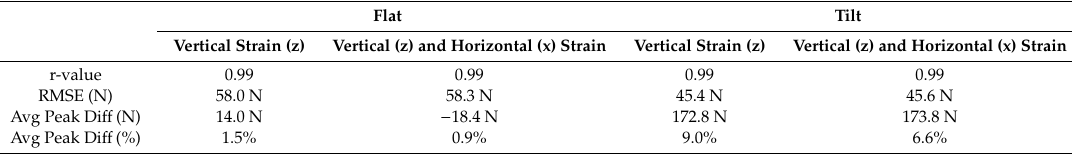
Table 2. E ff ects of blade tilt on blade force accuracy. The blade calibration was created from flat trials using signals from the three channels representing vertical strain or from all six channels representing vertical and horizontal strain. These calibrations were then applied to both flat and tilted trials (2.5 ◦ anterior tilt).